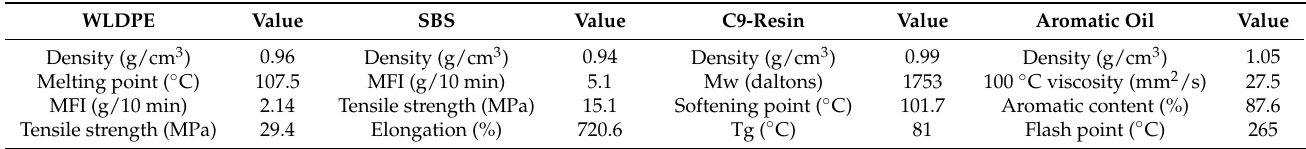
Table 2. Physical properties of WLDPE, RHDPE, SBS, C9-resin, and aromatic oil.